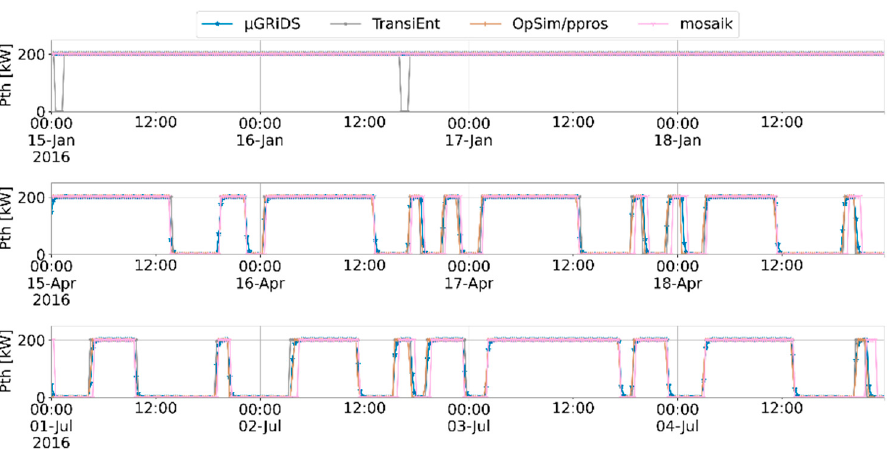
Figure 6. CHP thermal output for the different models in winter ( top ), transition ( mid ), and sum- mer ( bottom ) seasons.